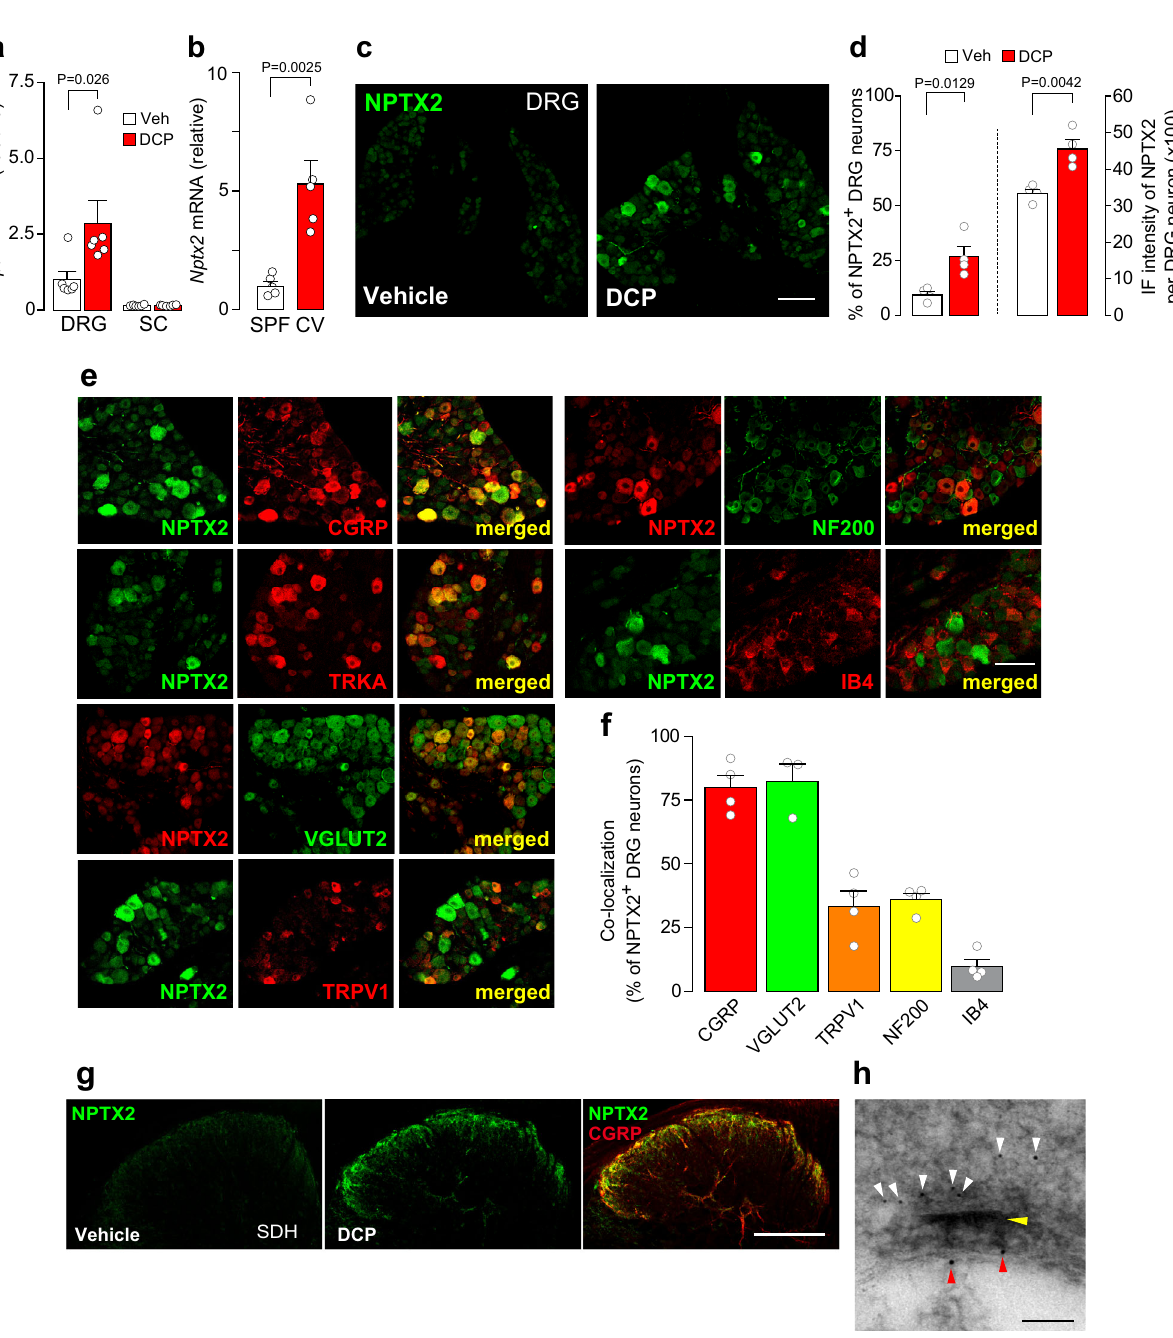
Fig. 2 Upregulation of NPTX2 expression in peptidergic DRG neurons under chronic itch-like conditions. a , b Nptx2 mRNA in the cervical DRG and spinal cord (SC) in vehicle- and DCP-treated mice ( a : n = 6/group, Mann – Whitney test) and in the cervical DRG in SPF- and CV-NC/Nga mice ( b : n = 5/group, unpaired t test). c NPTX2 immuno fl uorescence in the cervical DRG of vehicle- and DCP-treated mice. Scale bar, 100 μ m. d Percentage of NPTX2 + neurons in the cervical DRG and immuno fl uorescence (IF) intensity of NPTX2 per cervical DRG neurons in vehicle- and DCP-treated mice (n = 4/group, unpaired t test). e Double-immunolabeling of NPTX2 and DRG neuronal markers (CGRP, TRKA, VGLUT2, TRPV1, NF200, and IB4) in the cervical DRG in DCP-treated mice. Scale bar: 100 μ m. f Quantitative analysis of the percentage of NPTX2 + neurons colocalized with DRG neuronal markers in DCP-treated mice (CGRP; n = 4, VGLUT2; n = 3, TRPV1; n = 4, NF200; n = 4, and IB4; n = 4). g NPTX2 immuno fl uorescence in the cervical SDH of vehicle- and DCP-treated mice. In DCP-treated mice, NPTX2 (green) was colocalized with CGRP (red) in the SDH. Scale bar, 200 μ m. h Electron microscopy analysis of NPTX2 expression at presynaptic terminal connected to a postsynaptic GRPR + (mCherry + ) neuron in the SDH. NPTX2 and mCherry were visualized by small (white arrowheads) and large (red arrowheads) immunogold particles conjugating antibody for NPTX2 and mCherry, respectively. Yellow arrowhead indicates the postsynaptic density site. Scale bar, 100 nm. Values represent mean ± S.E.M. Source data are provided as a Source Data fi